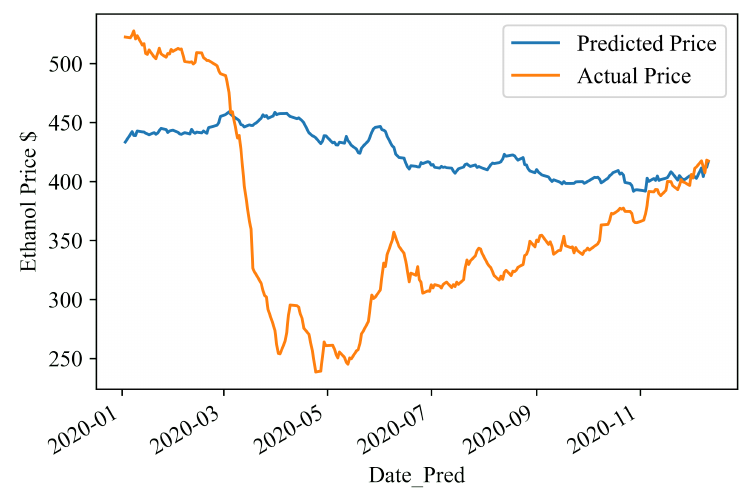
Figure 9. Predictions for 252 days